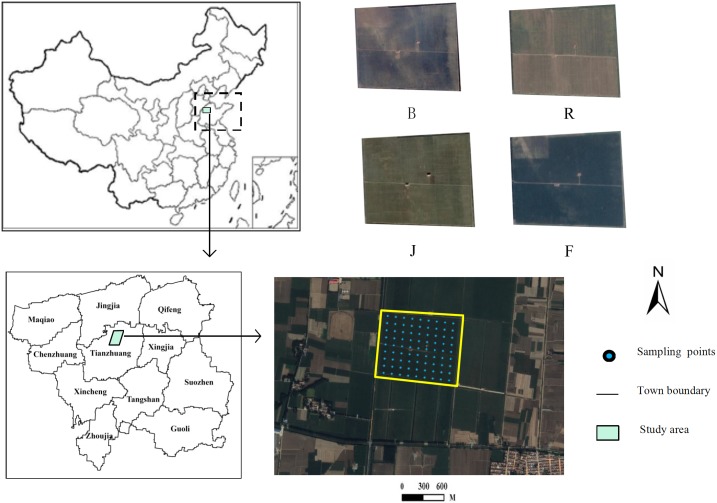
Location of the study area and distribution of soil sampling sites.Note: B: before sowing; R: reviving stage; J: jointing stage; F: filling stage.